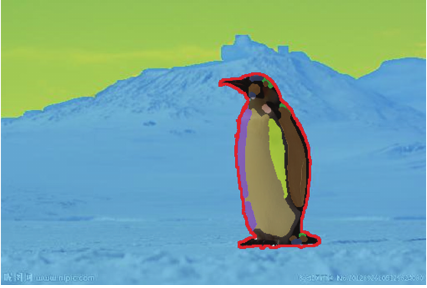
Figure 5: Real and compound